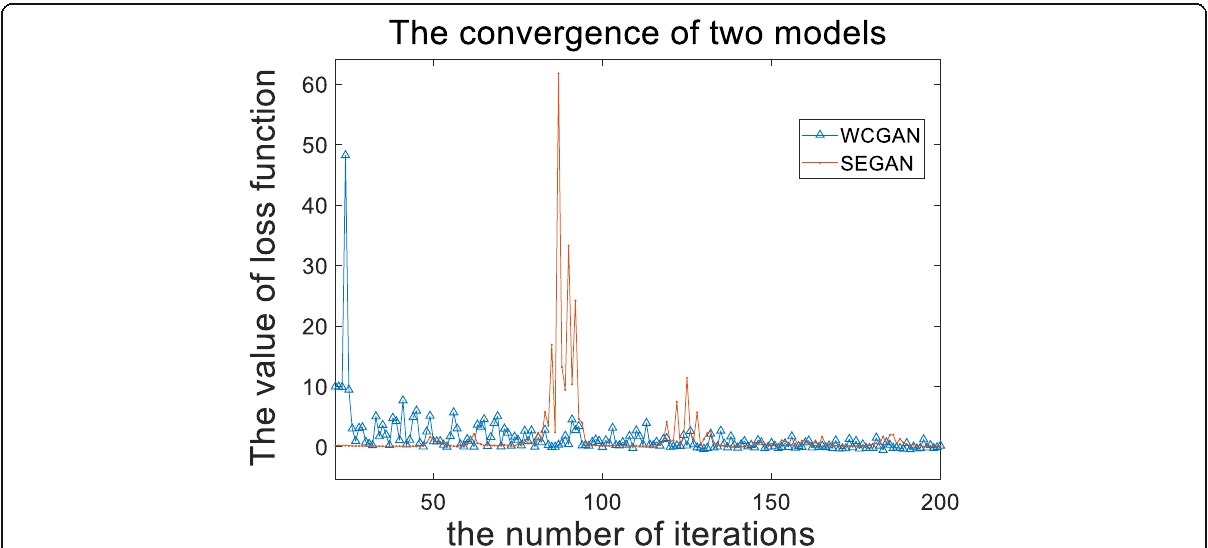
Fig. 4 The value of discriminator losses. The point labeled line is the loss function value of SEGAN model and the triangular labeled line is the loss function value of improved WCGAN model